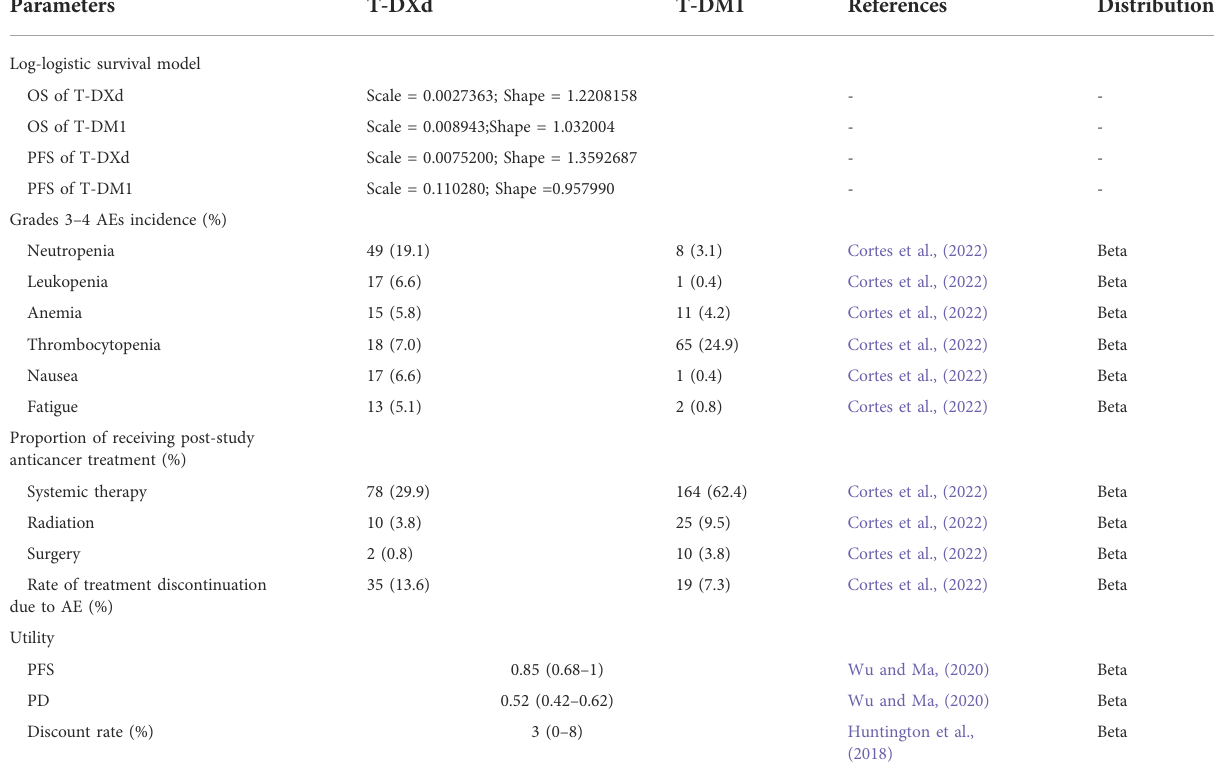
TABLE 1 Key clinical and health preference